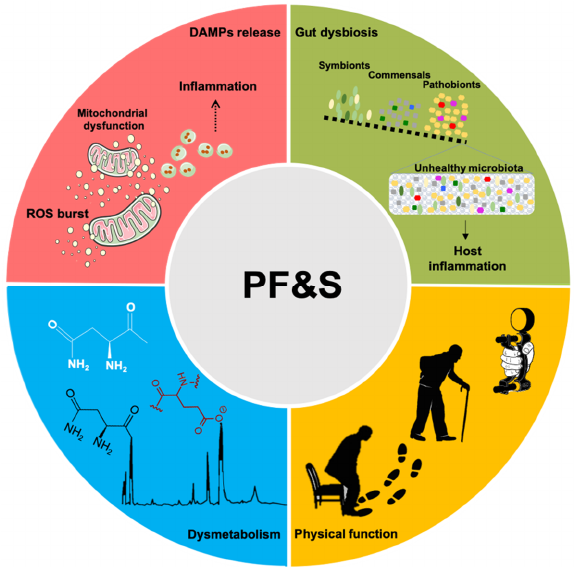
Figure 1. Schematic representation of the main pathophysiological pathways contributing to physical frailty and sarcopenia (PF&S) (i.e., inflammation, gut dysbiosis, declines in physical function, and dysmetabolism), and related biomarkers. Abbreviations: DAMPs, damage-associated molecular patterns; ROS, reactive oxygen